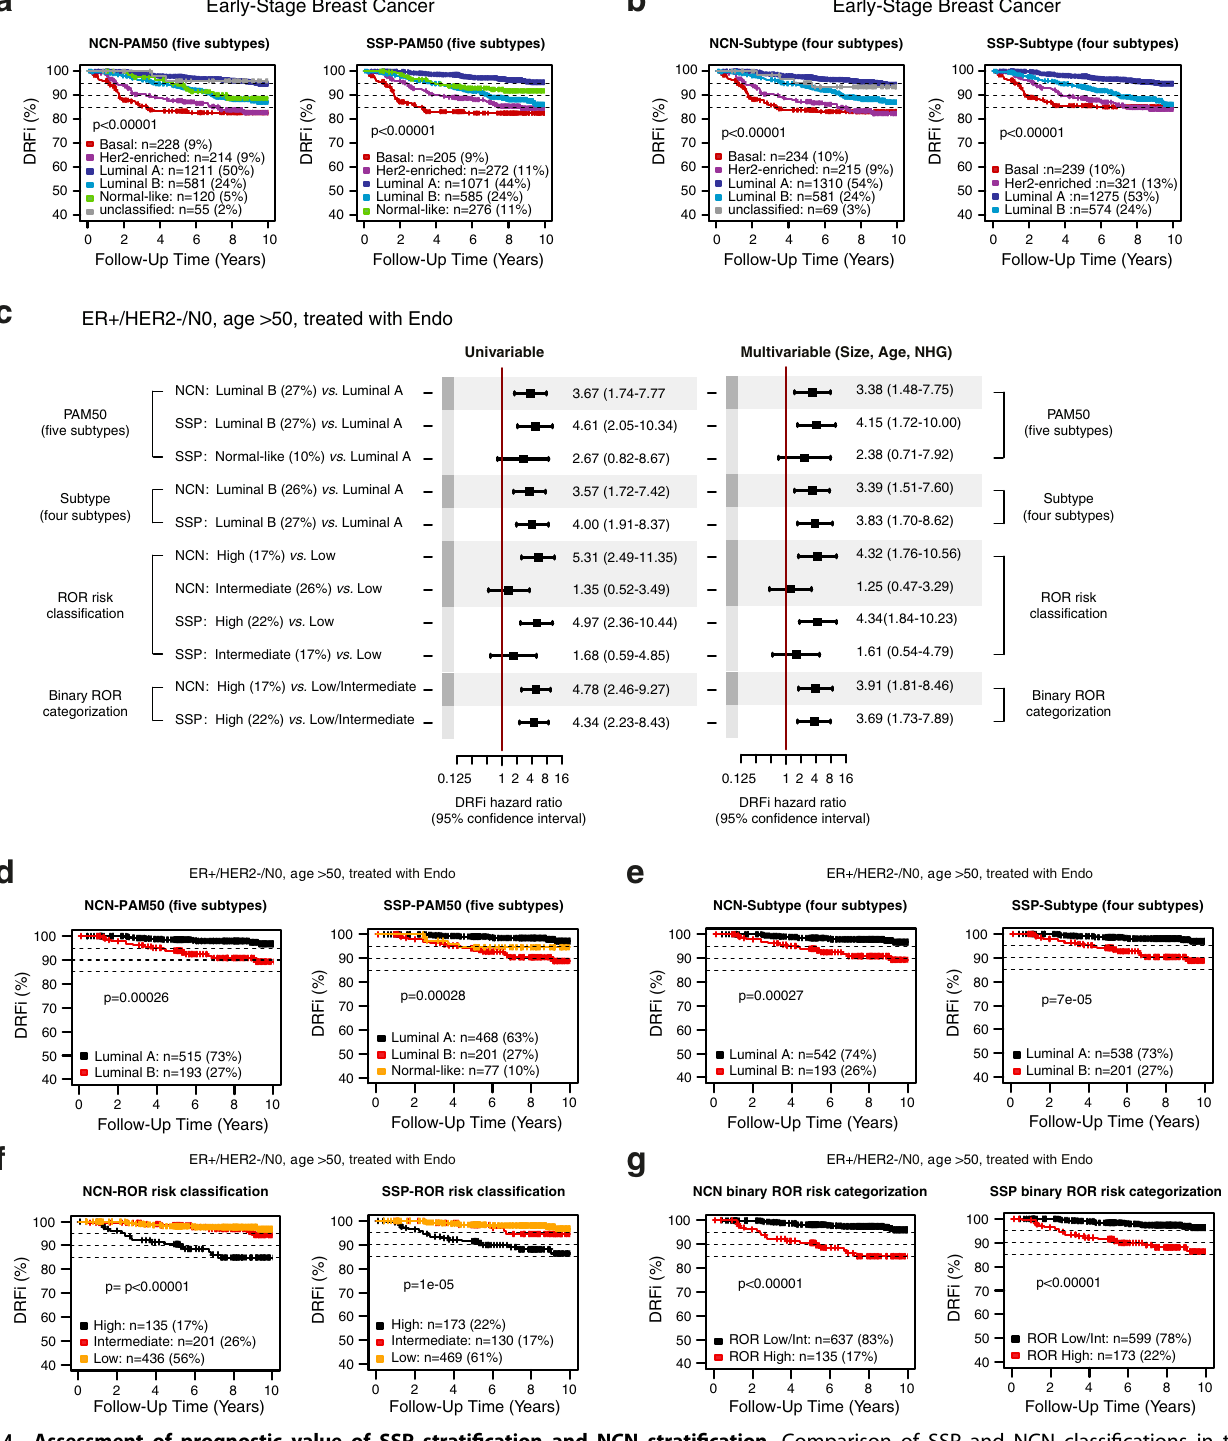
Fig. 4 Assessment of prognostic value of SSP strati fi cation and NCN strati fi cation. Comparison of SSP and NCN classi fi cations in the independent population-based test set by assessment of prognostic value. Kaplan-Meier plots for molecular subtype with fi ve groups (PAM50) or four groups (Subtype) using DRFi as clinical endpoint: a PAM50 by NCN (left) and SSP (right), b Subtype by NCN (left) and SSP (right). c Cox regression analysis using DRFi as endpoint in the test set restricted to patients with ER + /HER2-/N0 disease diagnosed over 50 years of age that only received endocrine adjuvant treatment ( n = 772). Test and reference group is speci fi ed on the left. Hazard ratios and 95% con fi dence interval ranges from univariable analysis (left forest plot) and multivariable analysis (right forest plot) with tumor size, age at diagnosis, and NHG as covariates. Kaplan – Meier plots for strati fi cation of ER + /HER2-/N0 disease diagnosed over 50 that only received endocrine adjuvant treatment in the test set by NCN (left in each panel) and SSP (right in each panel) for: d PAM50 subtype, e Subtype, f ROR risk classi fi cation, and g the two-group ROR strati fi cation according to Bartlett et al. 5 . Error bars correspond to 95% con fi dence